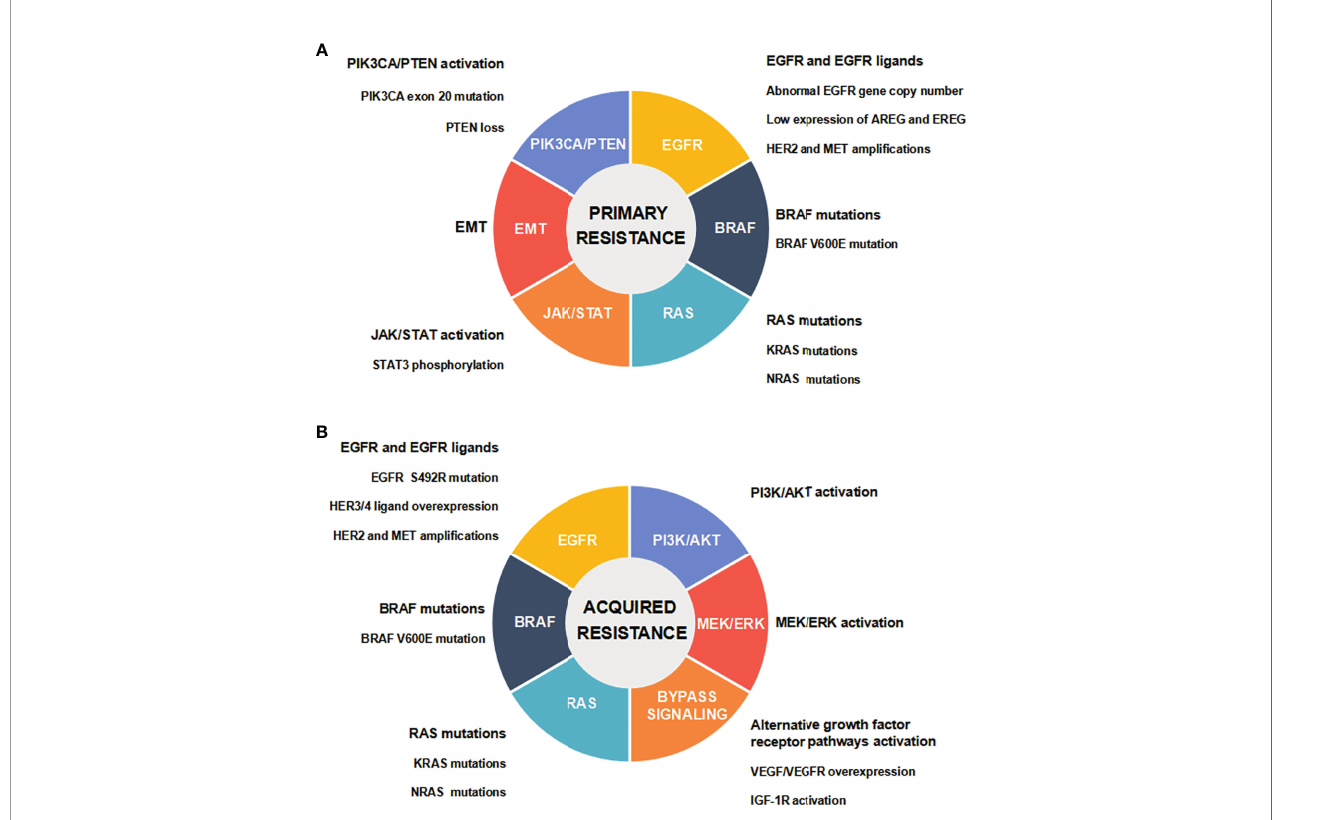
FIGURE 1 | Mechanisms of anti-EGFR drug resistance in CRC. (A) Primary resistance mechanisms. (B) Acquired resistance